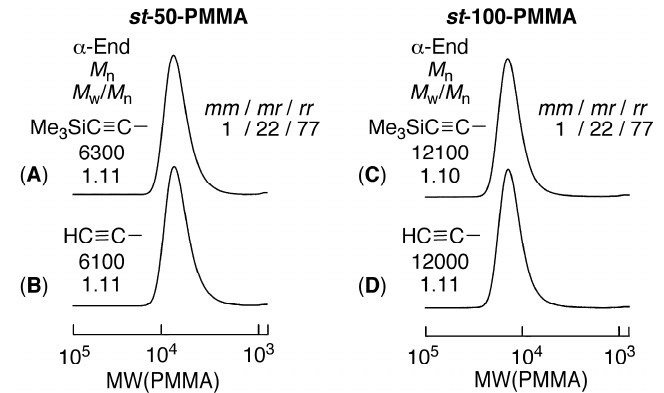
Figure 3. SEC curves of a series of st -PMMAs (( A , B ): st -50, ( C , D ): st -100) obtained in DPHLi/ 1 in THF at − 100 °C and subsequent procedures: ( A , B ) Quenching the polymerization ([M] 0 /[DPHLi] 0 /[ 1 ] 0 = 924/34/51 or 1870/34/51 mM) with acidic methanol; ( C , D ) Deprotection of Me 3 Si-group by n -Bu 4 NF in THF at 0 ◦ C ([Me 3 Si–] 0 /[ n -Bu 4 NF] 0 = 10/20